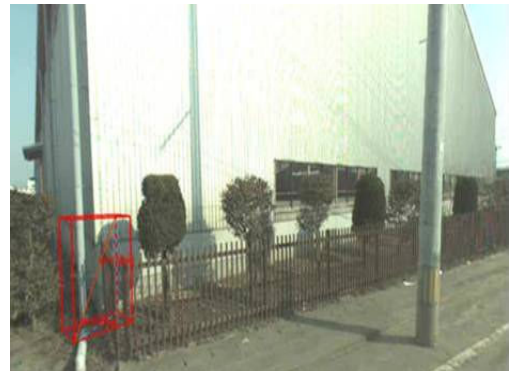
Figure 3. Measurement of tsunami flooded depth by